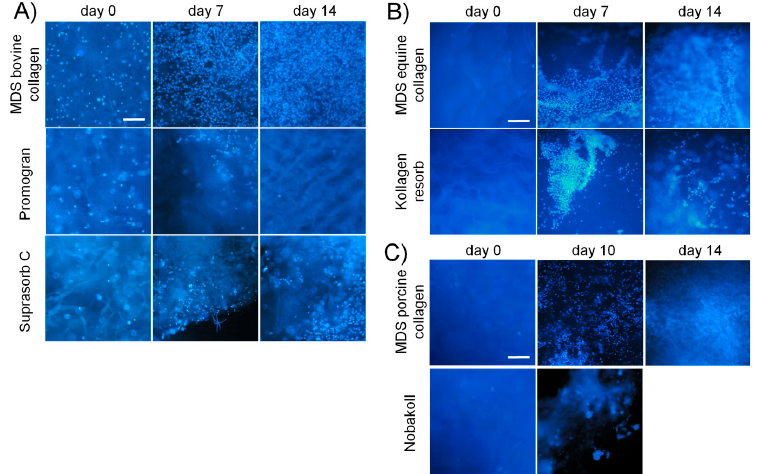
Figure 3. DAPI images of collagen matrices seeded with NIH 3T3 fibroblasts and incubated up to two weeks: ( A ) bovine matrices; ( B ) equine matrices; and ( C ) porcine matrices. Scale bars represent 200 µm.